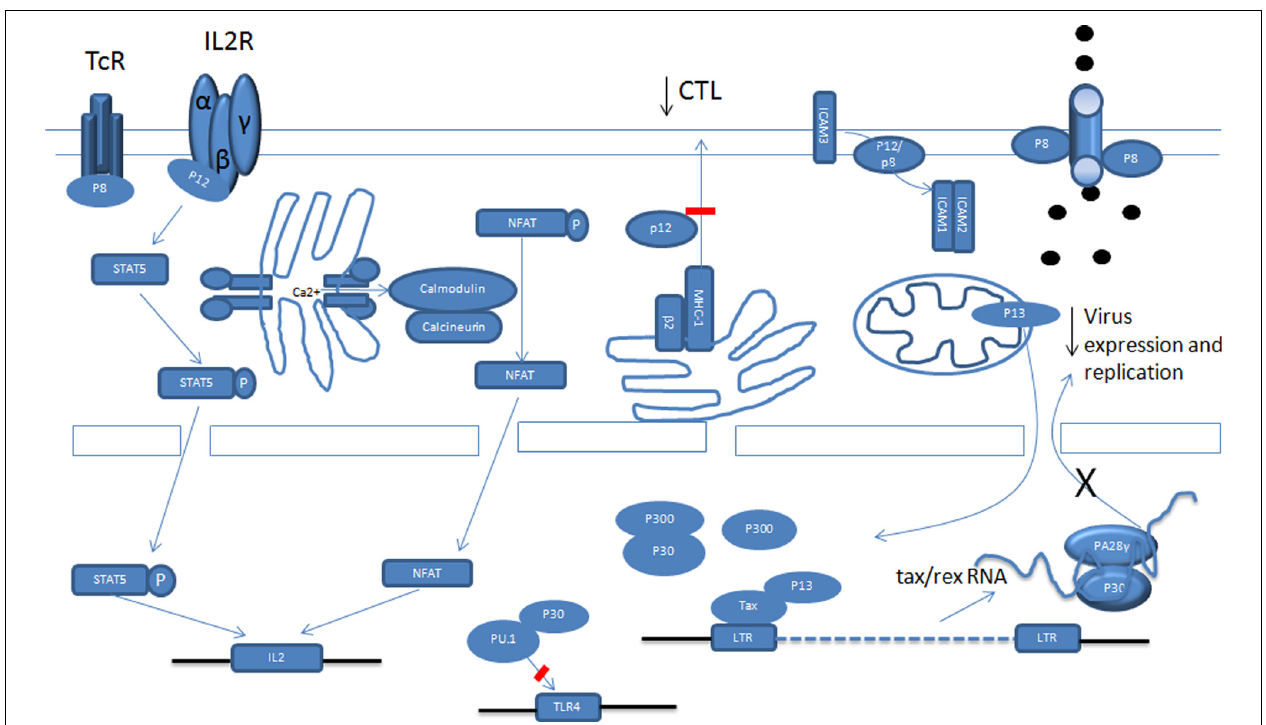
FIGURE 1 | Schematic functional representation of p12, p8, p30 and p13 in HTLV-1 infection.